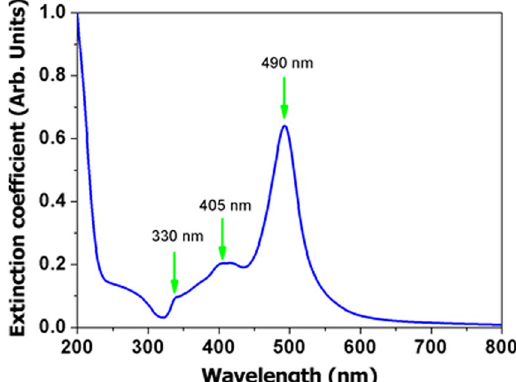
Figure 9. Extinction spectrum of silver nanoprisms in aqueous solution. Notice that the plasmon resonance of the Ag nanoprisms is in resonance with both excitation laser and RL emission